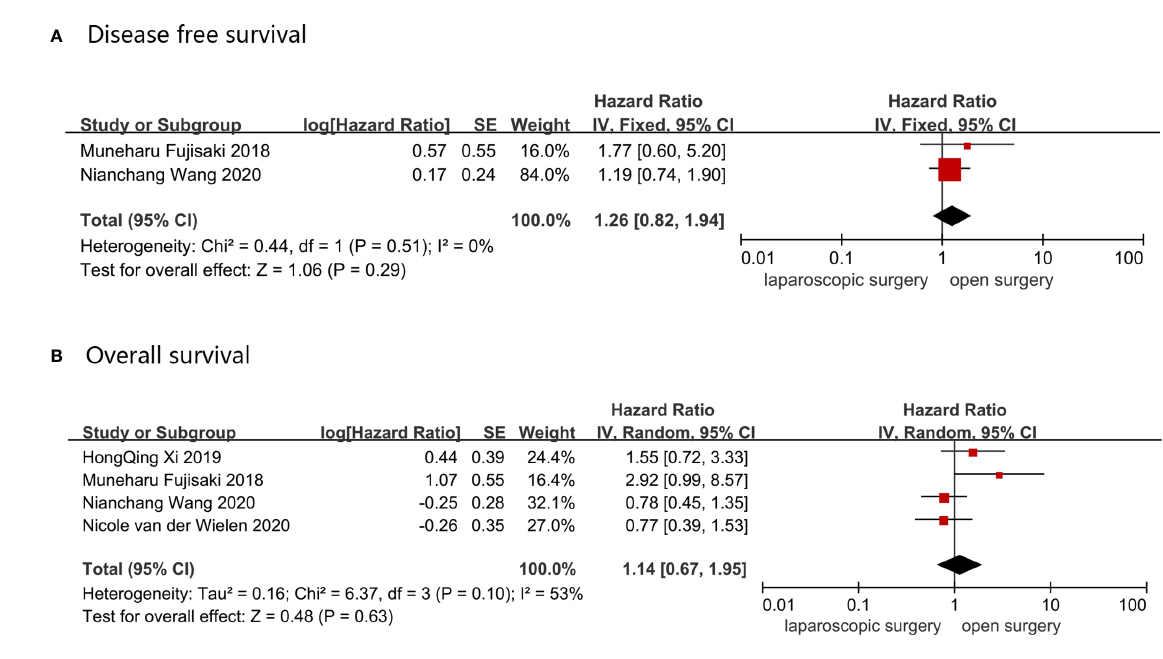
FIGURE 4 | Postoperative survival outcomes: (A) Disease free survival; (B) Overall